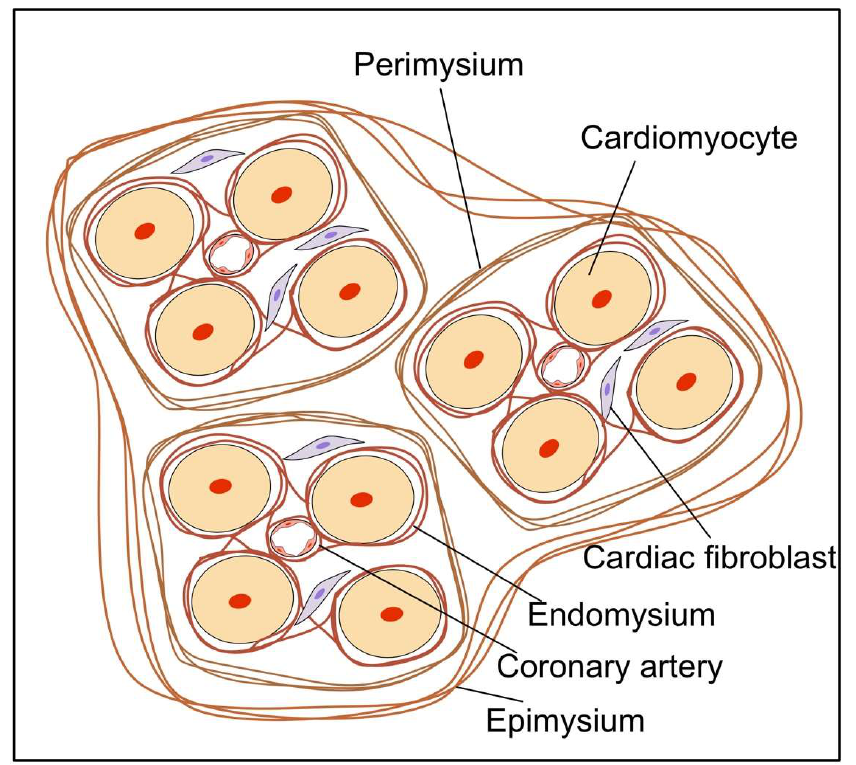
Figure 1. Schematic image of the cardiac interstitial collagen network. The endomysium surrounds and interconnects individual cardiomyocytes. The perimysial weave segregates cardiomyocytes into groups. The epimysium surrounds and clusters large numbers of myofibres.